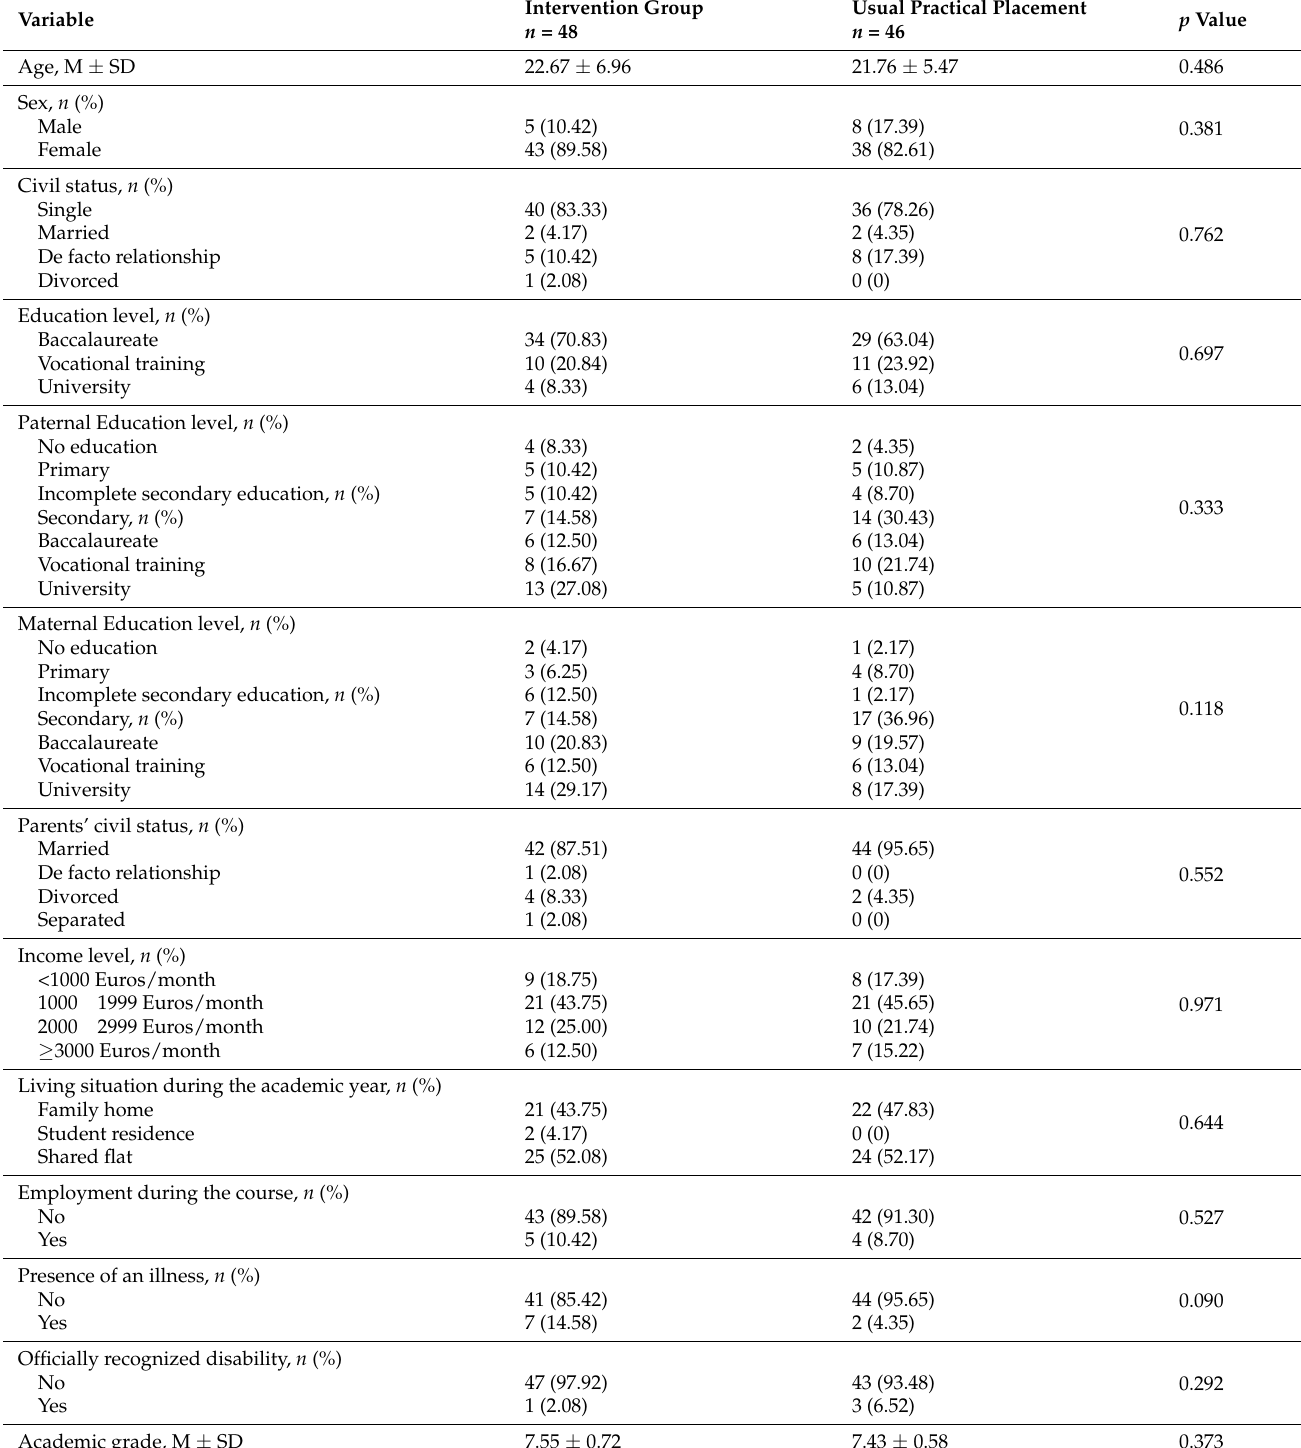
Table 1. Characteristics of the study